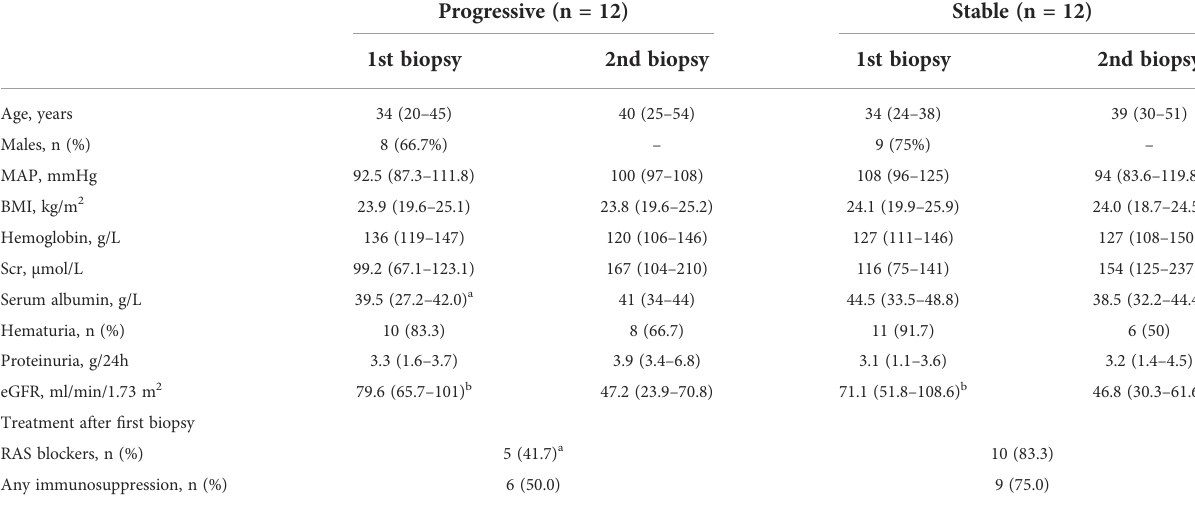
TABLE 1 Clinical data of patients with IgA nephropathy at the time of fi rst and second renal